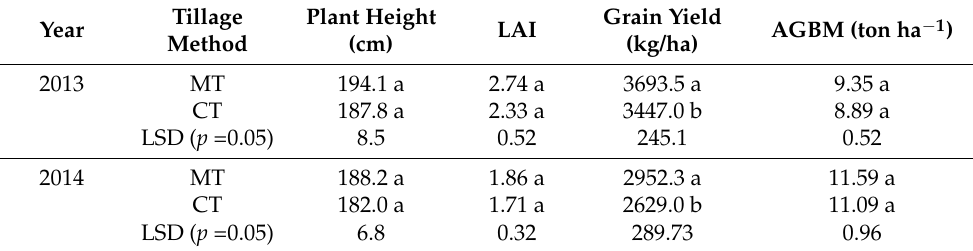
Table 3. Agronomic performance of locally adapted conservation tillage